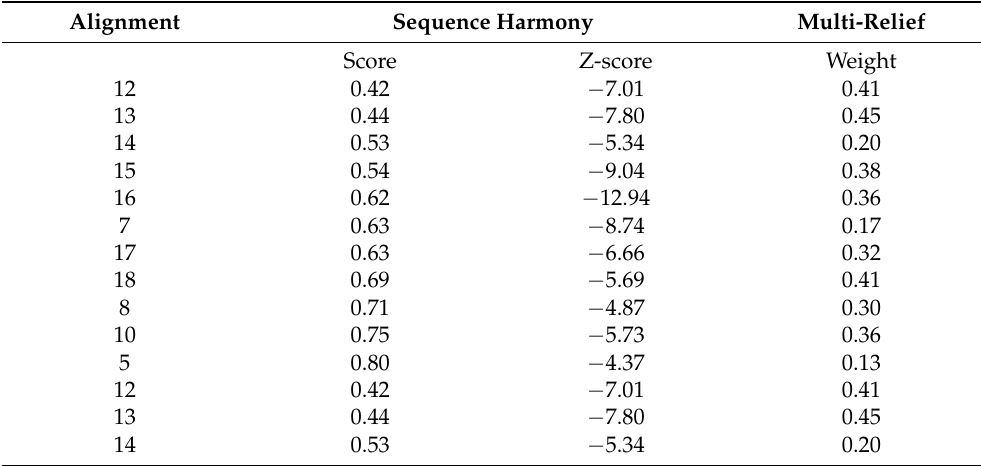
Table 3. Multi-harmony structural element analysis scores.